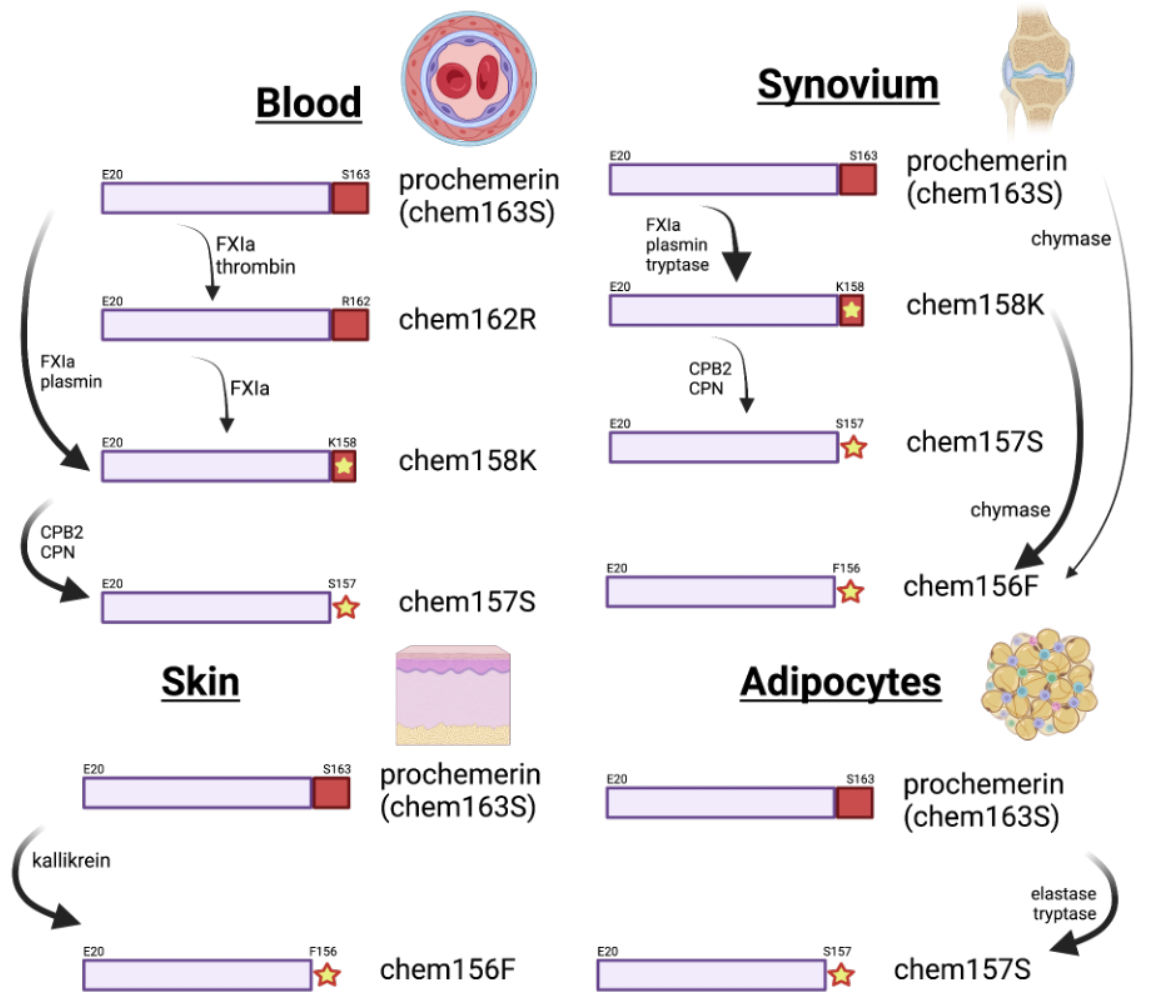
Figure 5. Processing of chemerin in various tissues or cells. These diagrams depict the enzymes that have been proven to be involved in chemerin processing in the tissues or cells. In blood, the cleavages are shown following activation of coagulation and fibrinolysis; in synovium, from patients with rheumatoid arthritis; in skin, in patients with psoriasis, and in adipocytes that have been stimulated with TNF- α . Created with BioRender.com.